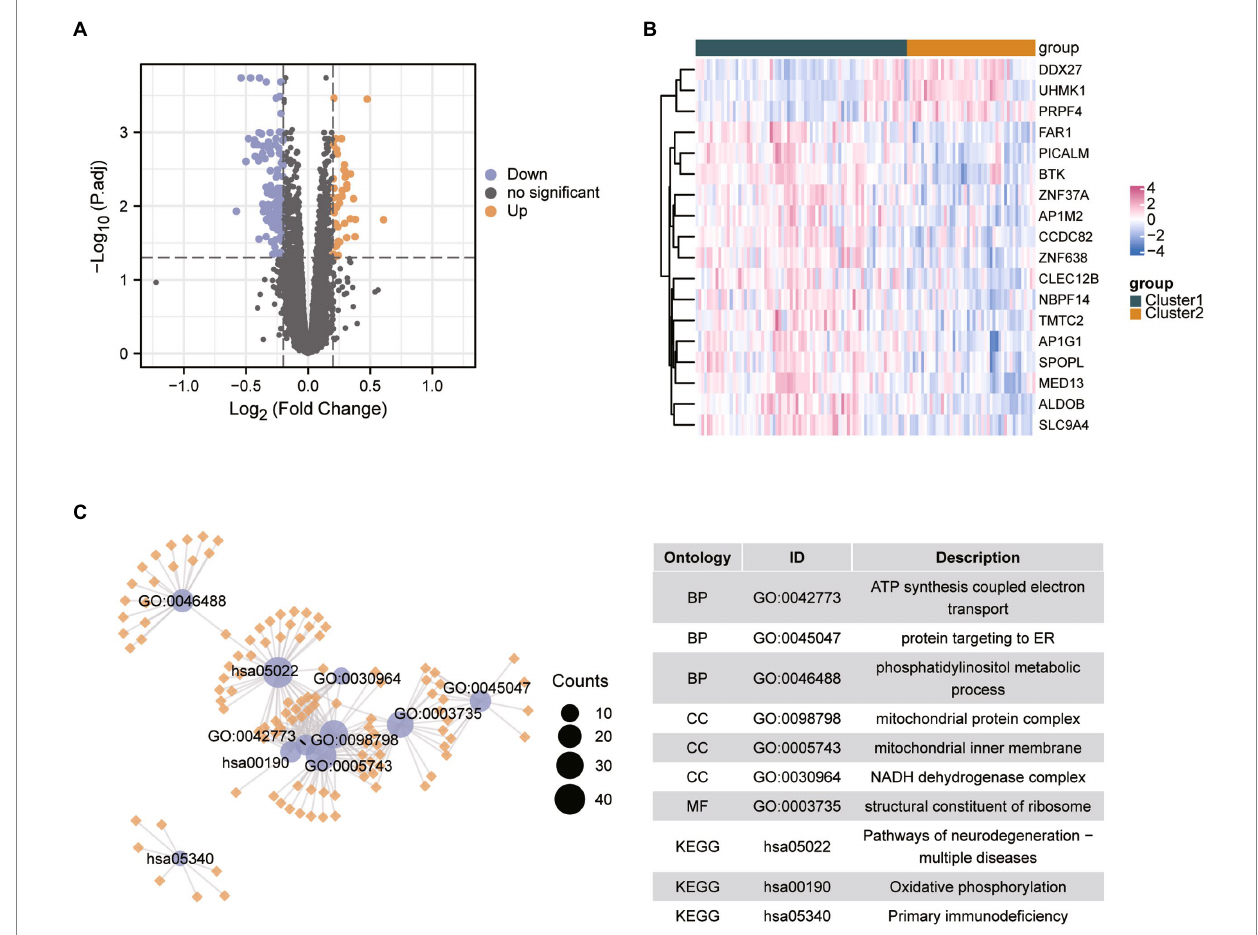
FIGURE 6 Identification of the differential expressed genes between different clusters in ASD. (A,B) Volcano plot and heatmap showed the differential expressed genes in ASD cluster 2 compared with the ASD cluster 1. (C) GO and KEGG enrichment analysis based on the differential expressed genes between ASD clusters. Abbreviations: BP, biological processes; CC, cellular components; MF, molecular